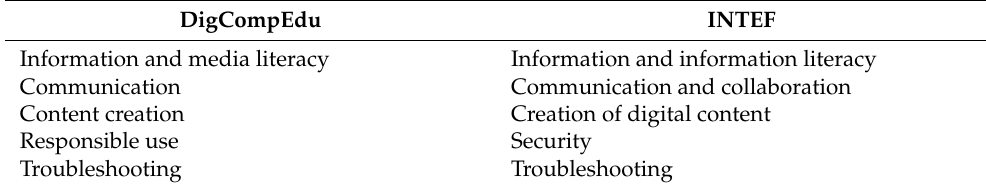
Table 9. Competencies assessed by the frameworks.